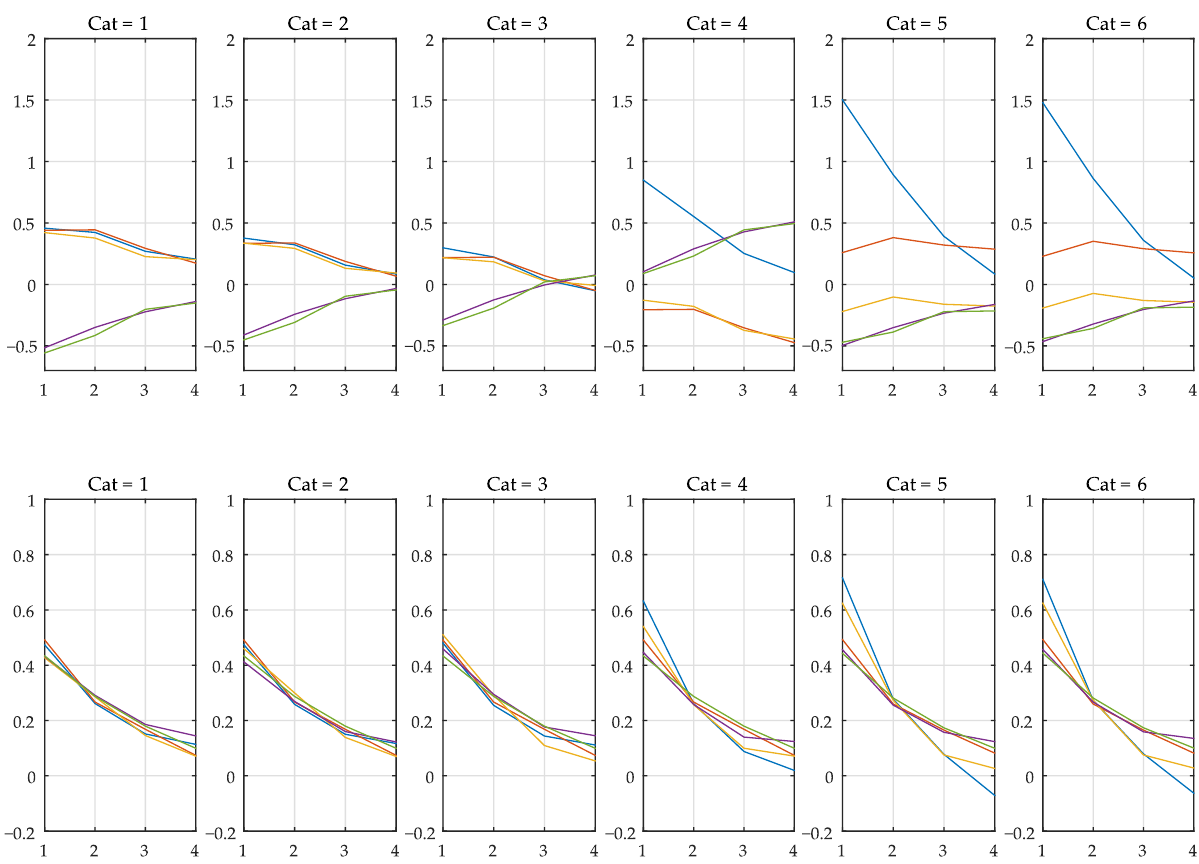
Figure 5. Map (first row) and prediction (second row) weights in the training phase, for the first six (from 16; see Figure 3) time-series segments. Each line in a graph represents the j -th group of coefficients associated with measurement m j n